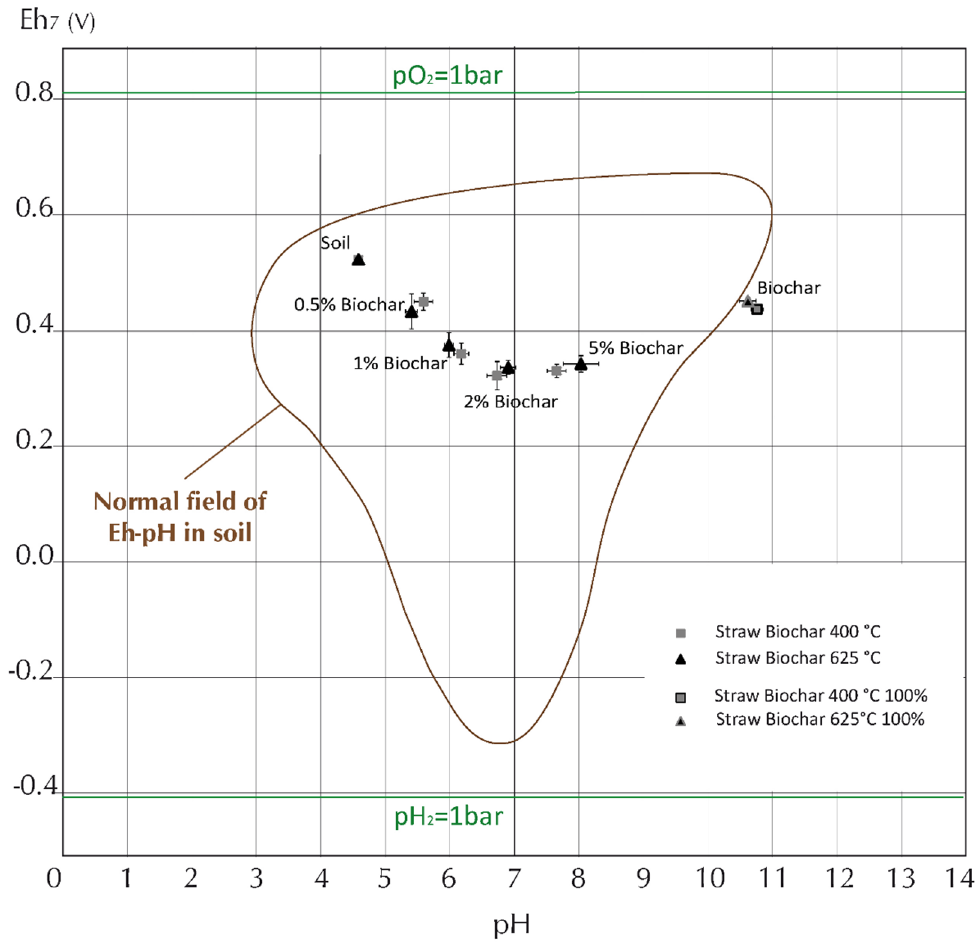
Figure 6. Summary of information on measurement on the change in Eh (corrected for pH) and pH with the addition of 2 rice straw biochars produced at 400 °C and 625